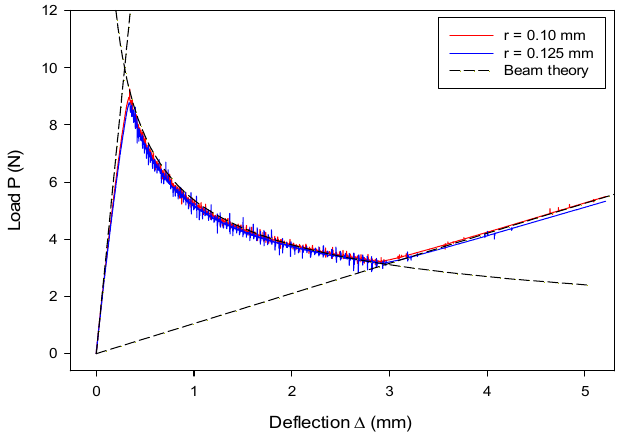
Figure 12. Size effect due to varying particle radius on the DCB model.